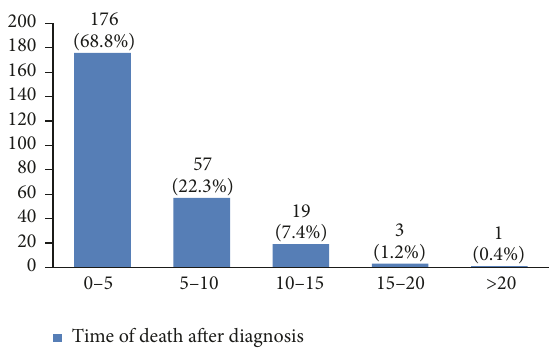
Figure 36: The time of death after breast cancer diagnosis in the studied